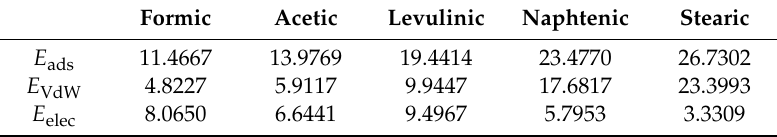
Table 3. Adsorption energies of acids when interacting stably with cellulose (kcal / mol). Formic